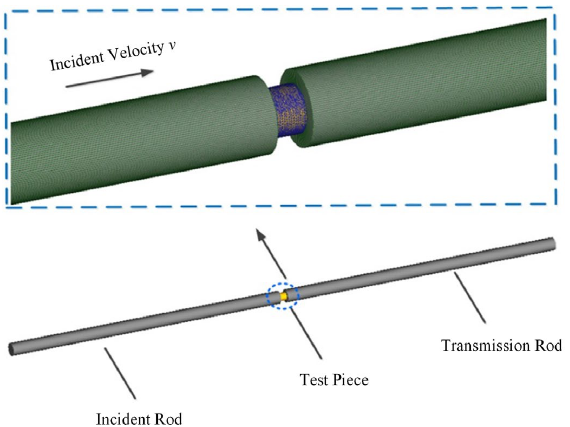
Figure 12. Schematic diagram of dynamic impact compression finite element model.